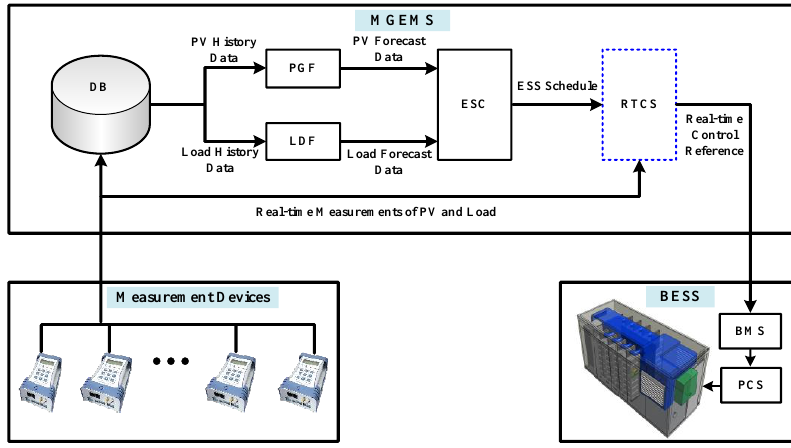
Figure 3. Schematics of real-time control of BESS.